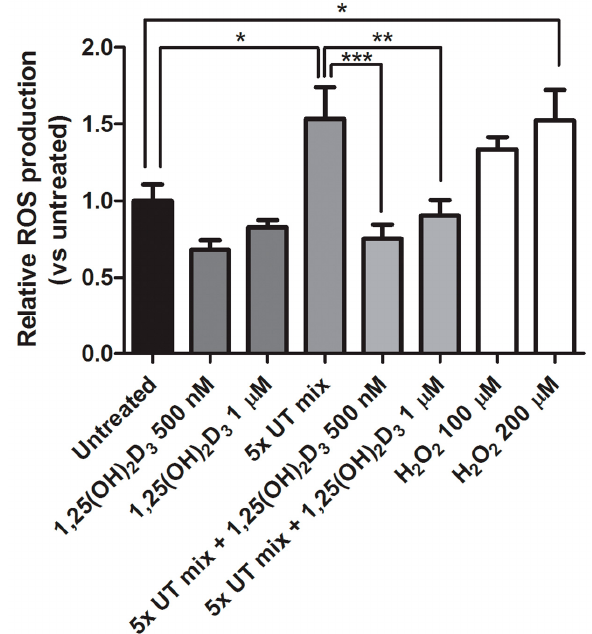
Figure 4. Vitamin D effect on intracellular ROS production in ciPTEC-OAT1. Relative ROS production in ciPTEC-OAT1 after 2 h exposure to 1,25(OH) 2 D 3 (500 nM and 1 μ M), 5× UT mix, combination of the two at previous concentrations and H 2 O 2 (100 μ M and 200 μ M). Three independent experiments were performed in duplicate. * p < 0.05, ** p < 0.01, *** p < 0.001 (One-way ANOVA followed by Dunnett’s multiple comparison test, using as a control either untreated sample or 5× UT mix, as indicated).